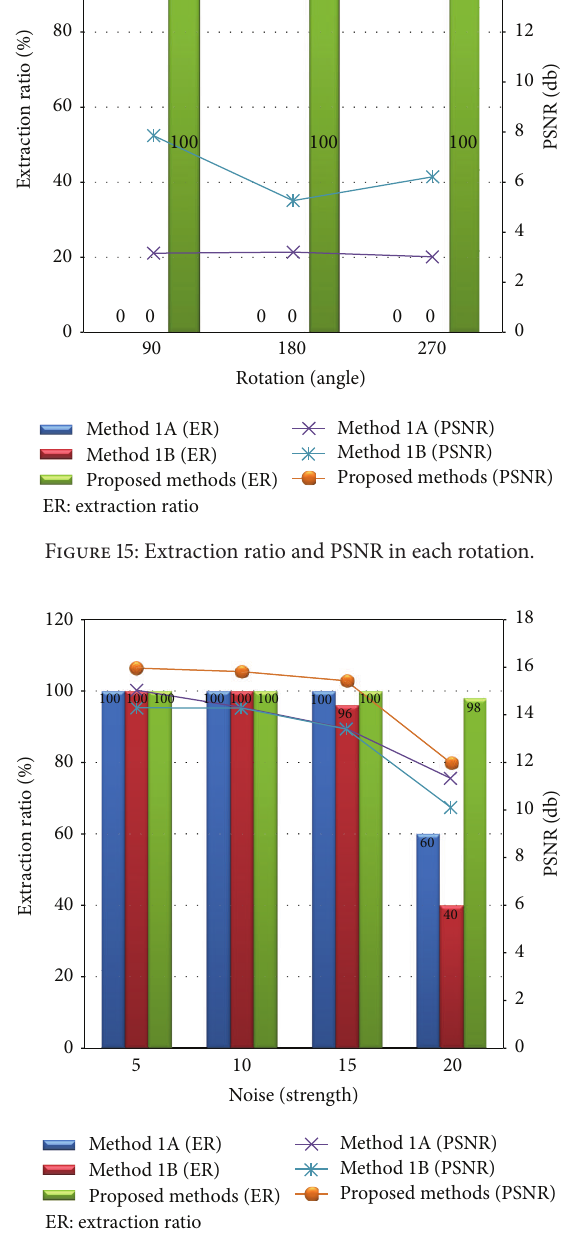
Figure 16: Extraction ratio and PSNR in each